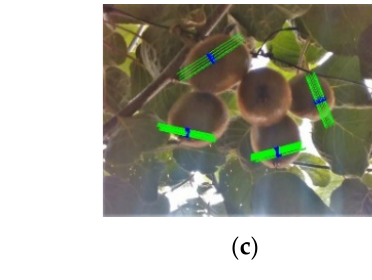
Figure 5. Visualization results of the grasping labels: ( a ) SF, ( b ) LC, ( c ) OC.